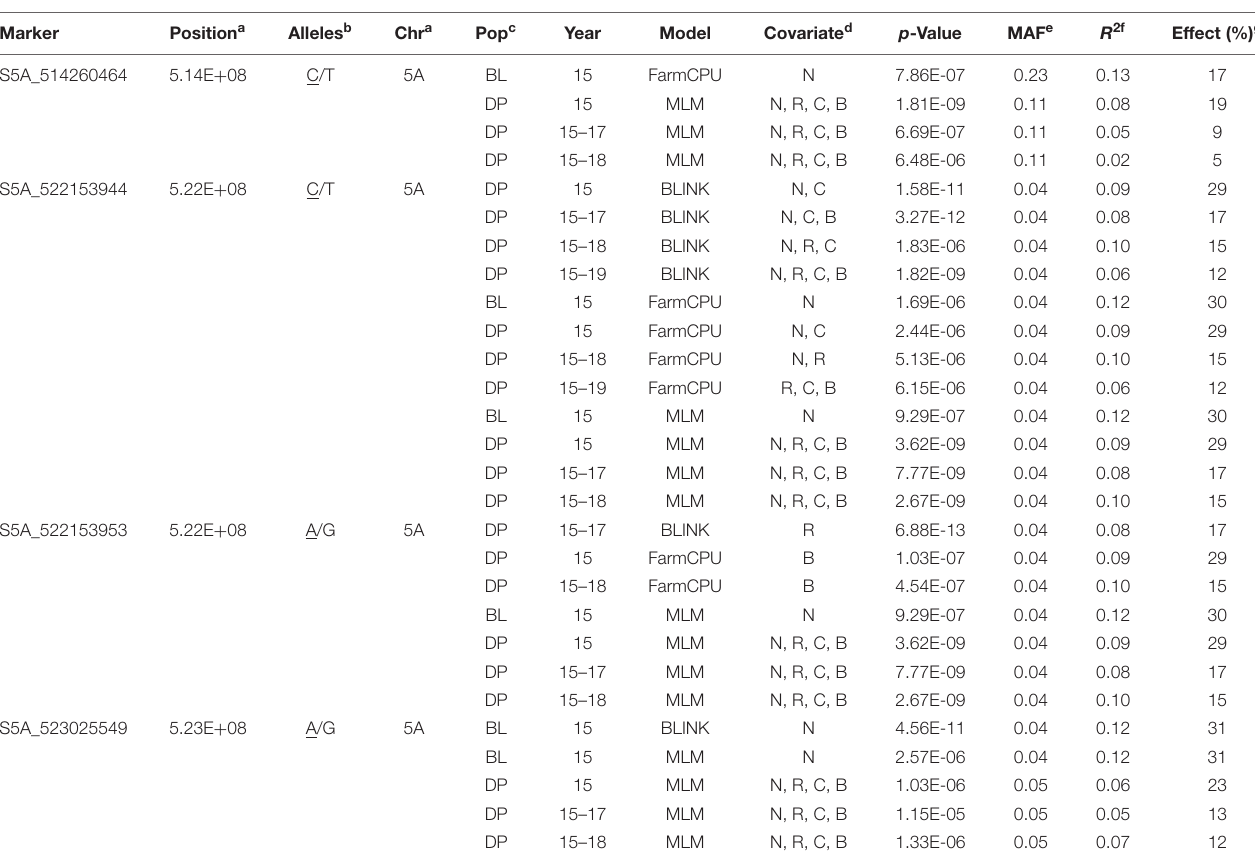
TABLE 5 | Consistent significant markers across both the diversity panel and breeding lines for controlling deep-sowing seedling emergence in a Pacific Northwest winter wheat breeding trial using BLINK, FarmCPU, and ML genome-wide association studies (GWAS) models using covariates for coleoptile length and Rht alleles. Marker Position a Alleles b Chr a Pop c Year